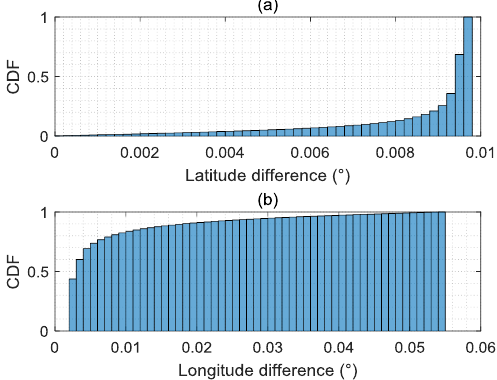
Figure A3. Estimated cumulative density function (CDF) for the latitude differences and longitude differences between the two nearest pixels along CloudSat ground track randomly chosen, the 48,817 granule from 2015, ( a ) latitude difference and ( b ) longitude difference.